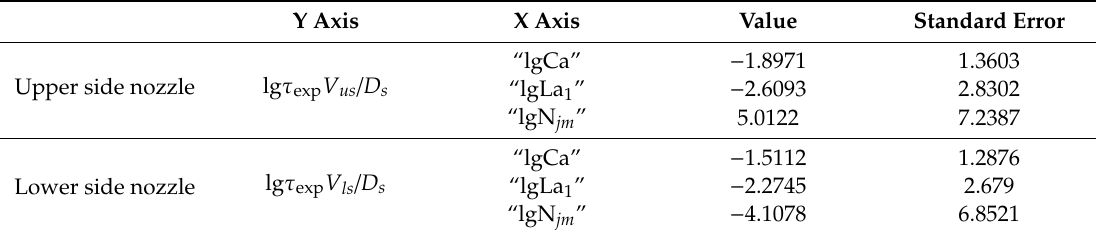
Table 7. Value and standard error of lg Ca, lg La 1 , and lgN jm by multiple linear regression for upper side nozzle and low side nozzle.